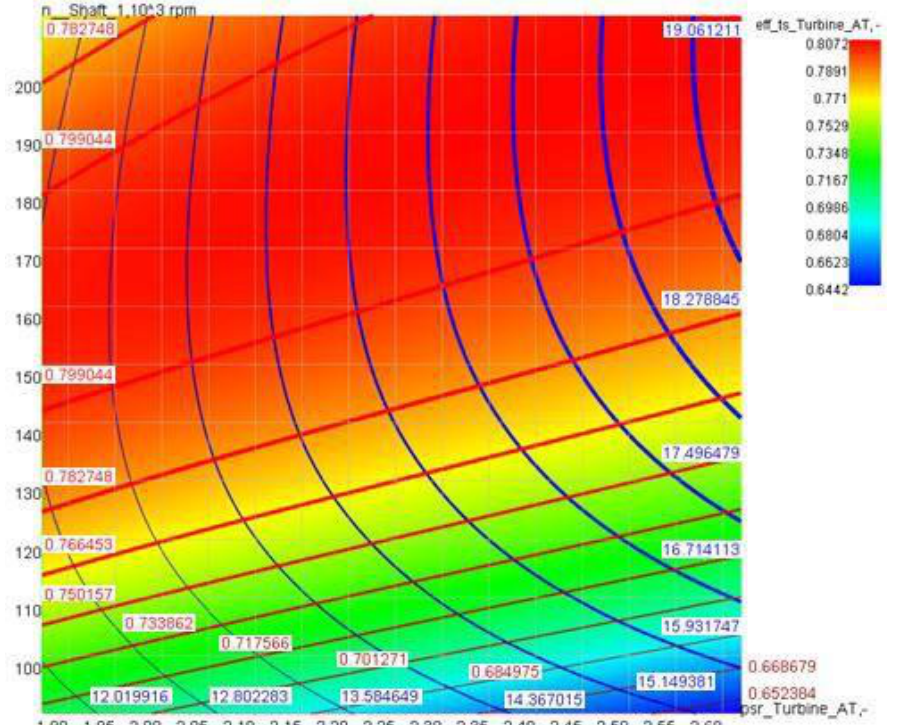
Figure 20. Prismatic Range 3 turbine map ( y -axis: shaft speed in rpm (1000 s); x -axis: turbine pressure ratio). The legend at the top right-hand side indicates the range of total-to-static turbine e ffi